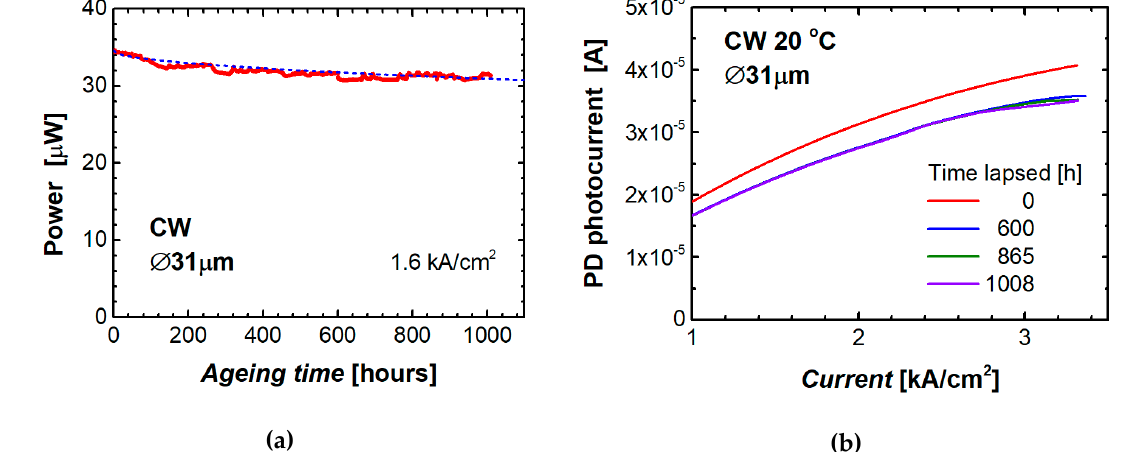
Figure 10. Ageing data for QD microdisk laser on silicon at a constant current density 1.6 kA / cm 2 ; dashed curve corresponds to P (t) / P (0) = (1 – a t m ) with a = 0.0031 and m = 0.51 ( a ). Photocurrent of monitor photodiode vs microlaser injection current measured during the test ( b ).